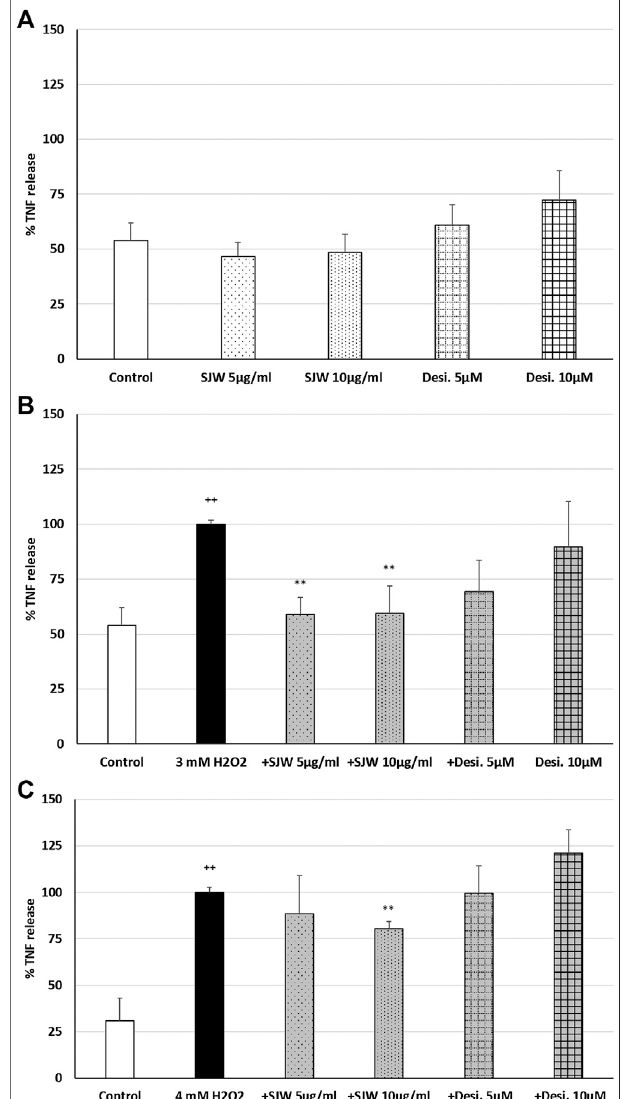
FIGURE 2| Effects of 48 h pre-treatment with STW3-VI [St. John ’ swort (SJW)] or desipramine (desi.) and afterwards 24 h co-incubation with (A) SJW or desi. alone, (B) 3 mM H 2 O 2 or (C) 4 mM H 2 O 2 on the TNF- α release in mouse SIM-A9 microglia. Data are given as mean + SEM; signi fi cance (by T-TEST): ** p < 0.01, *** p < 0.001 vs. 3 mM or 4 mM H 2 O 2 treated cells; ++ p < 0.01 vs. untreated control; n (cid:2)